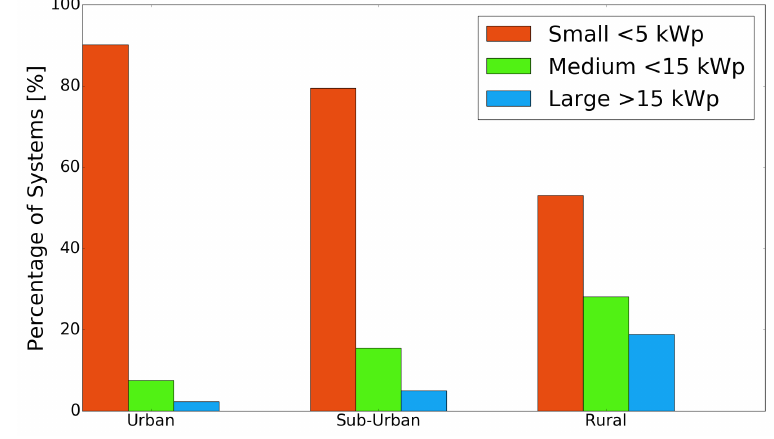
Figure 3. System size distribution per location.